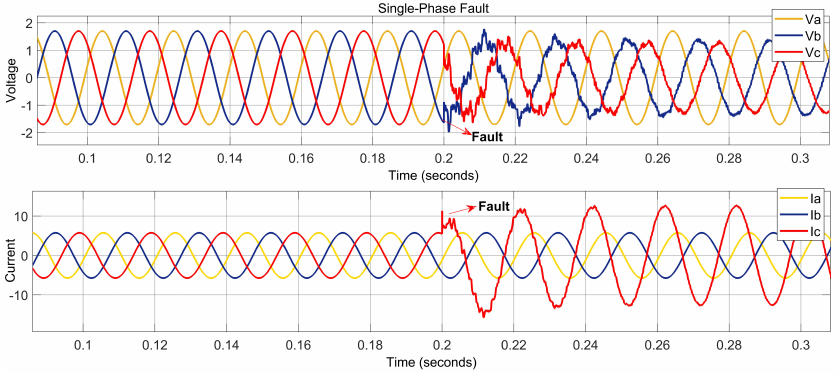
Figure 7. Single-phase to ground fault